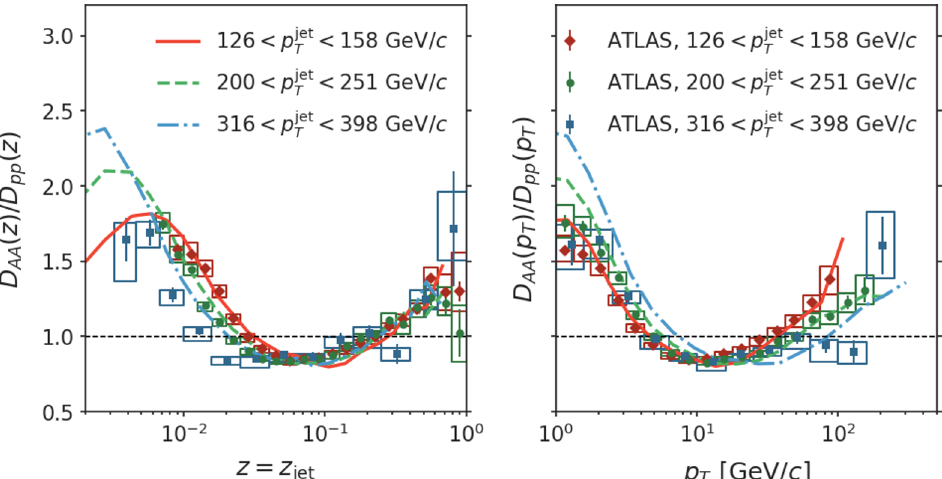
Figure 11 . An investigation of the scaling properties of the calculated jet fragmentation function in Pb-Pb collisions using the central prediction parameter set in table 1. Left: overlapping calculations and measurements of D ( z ) ratios for three different p jet bins. Right: left: overlapping calculations T and measurements of D ( p ) ratios for three different p jet T T